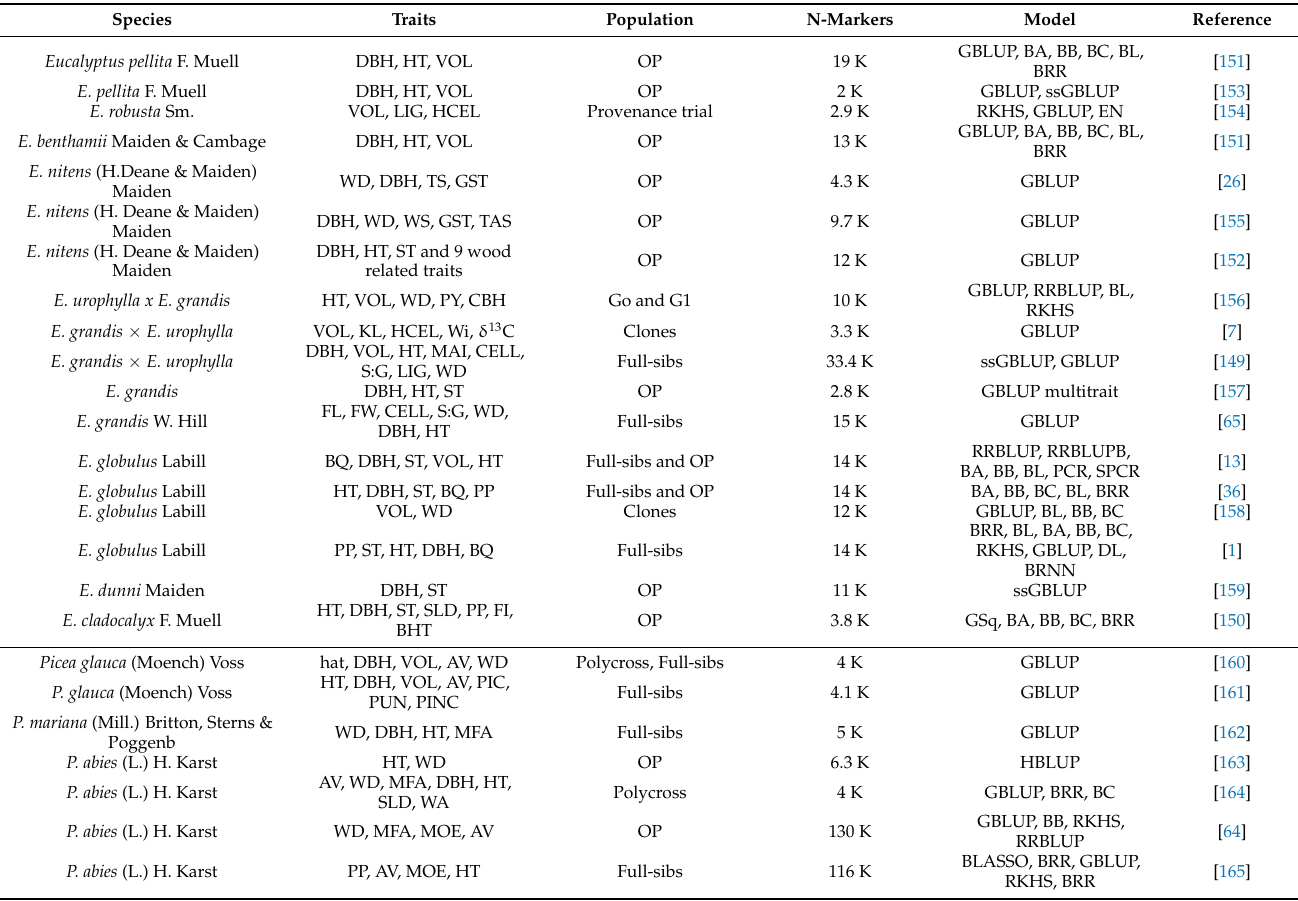
Table 2. Published studies on genomic prediction (GS) in forest tree species in the last 5 years. Population, N-Markers and Model criteria correspond to the type of population used to implement GS, number of markers and the prediction models, respectively. Species Traits Population N-Markers Model